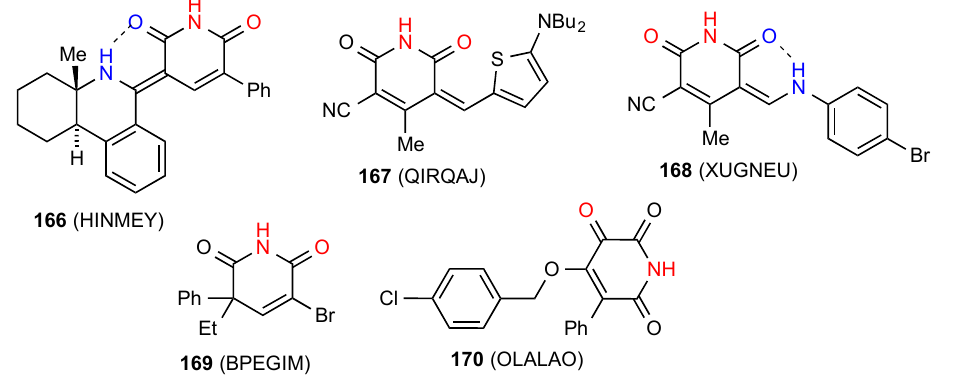
Figure 51. Unsaturated glutarimides showing patterns A and F.